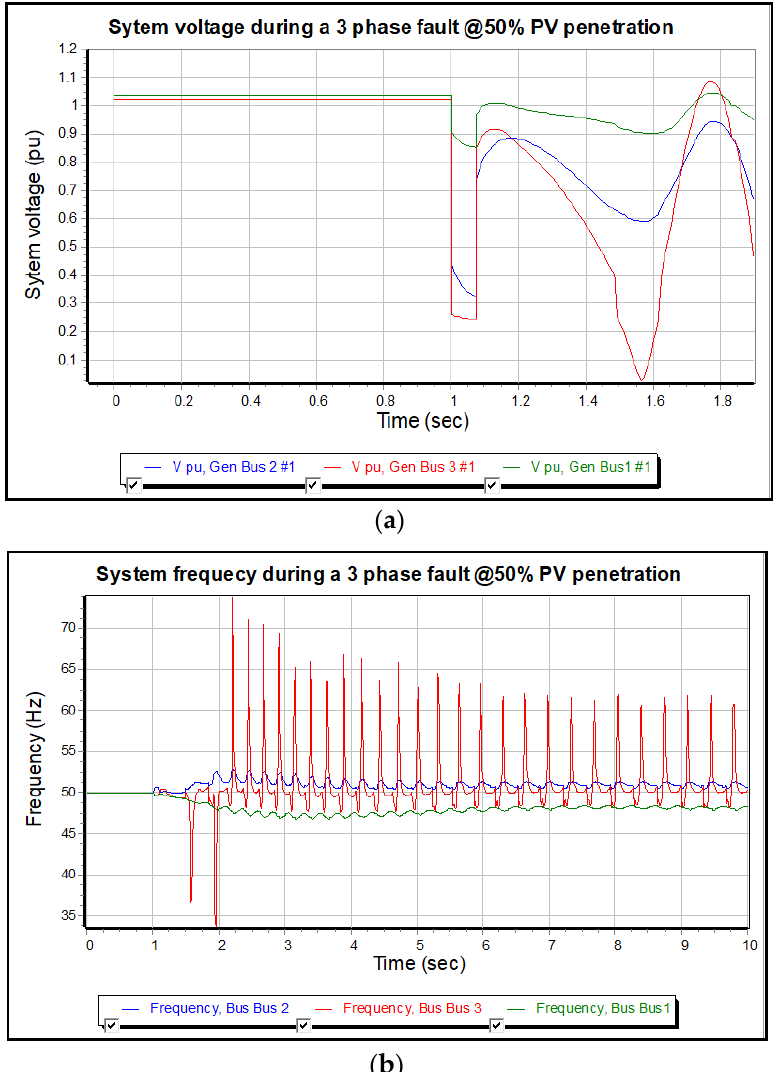
Figure 8. 3- φ fault simulation without flywheel at 50% PV Penetration: ( a ) voltage response; ( b ) system frequency response .